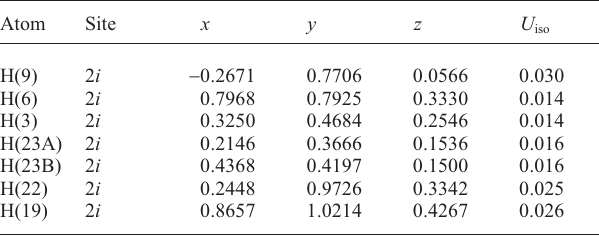
Table 2. Atomic coordinates and displacement parameters (in Å 2 )